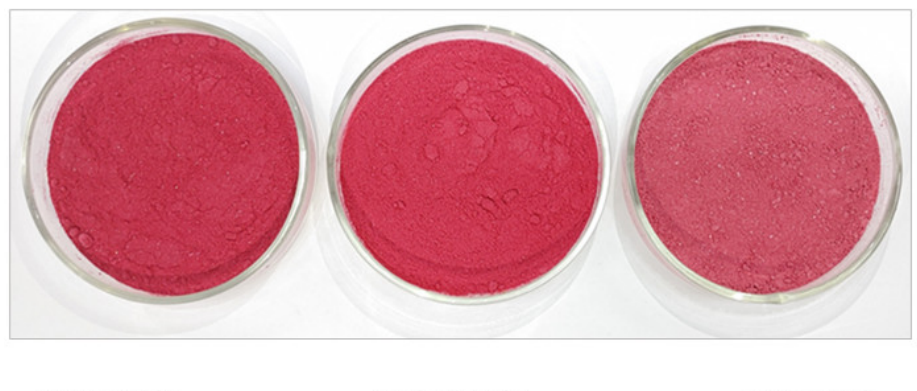
Figure 1. Representative photographs of gum Arabic, maltodextrin, and waxy starch encapsulated powders.